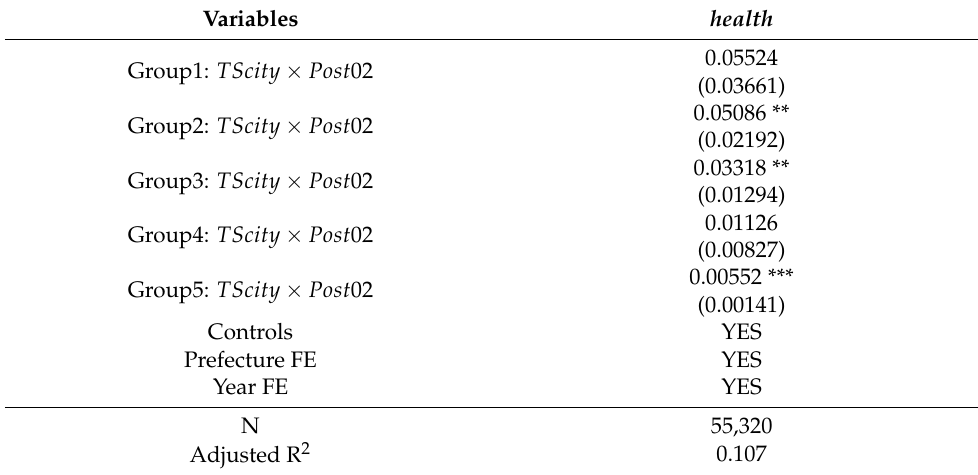
Table 6. Testing for